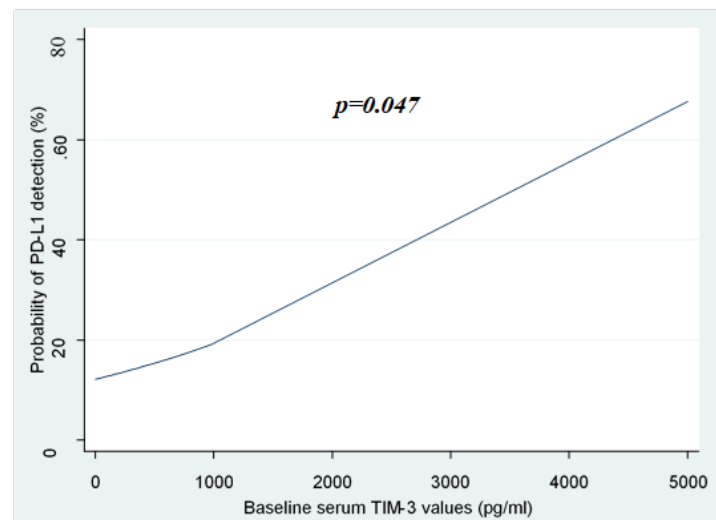
Figure 2. Association of sTIM-3 values with the probability of s PD-L1 detection. Higher sTIM-3 values were associated with a higher probability of sPD-L1 detection. Univariate logistic regression was used as a statistical model to show the probability of detection / no-detection of PD-L1 versus sTIM-3 values. sTIM-3; serum T-cell immunoglobulin and mucin domain-3, sPD-L1; serum Programmed death ligand-1.